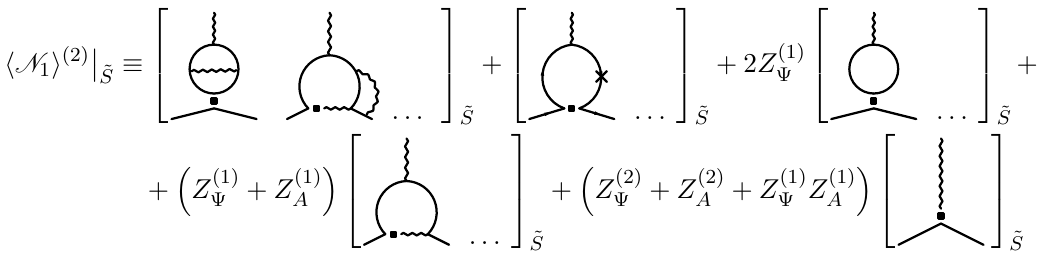
(cid:12) , with ~ S any of the structures in (cid:12) ~ S and Q 1 . 1 . 1